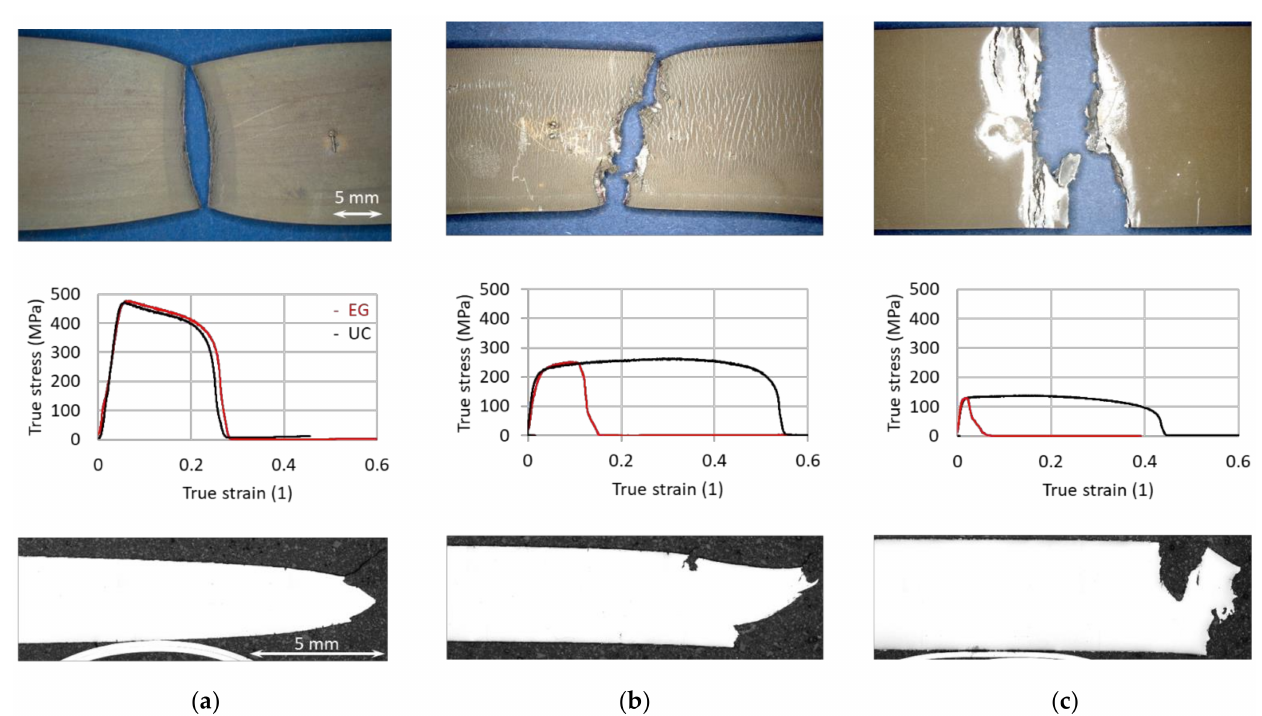
Figure 3. Macro documentation of the fracture surface (top view), stress-strain curves and micrographs of the axial cuts for EG samples with a strain rate of 0.1 (1/s) at ( a ) 600 ◦ C, ( b ) 725 ◦ C and ( c ) 900 ◦ C.